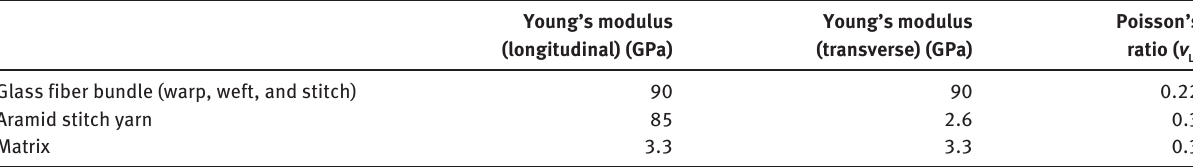
Table 5 Input values for the calculation of Young’s modulus of fiber bundle elements